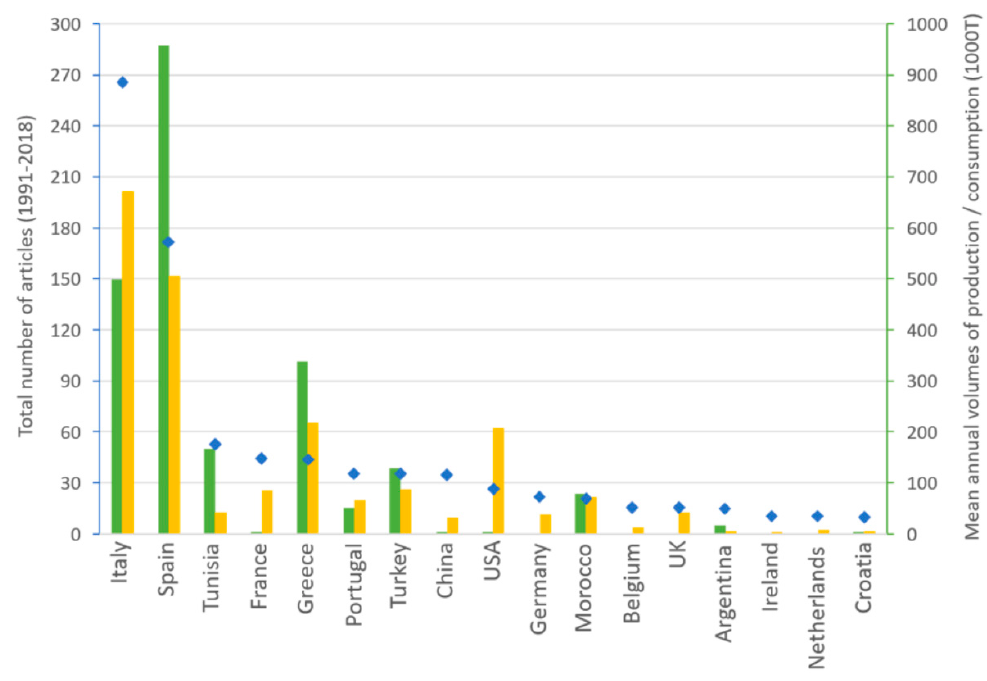
Figure 2. Annual volumes of olive oil production (green bars) and consumption (yellow bars) for the countries having published more than 10 articles (blue diamonds) between 1991 and 2018.